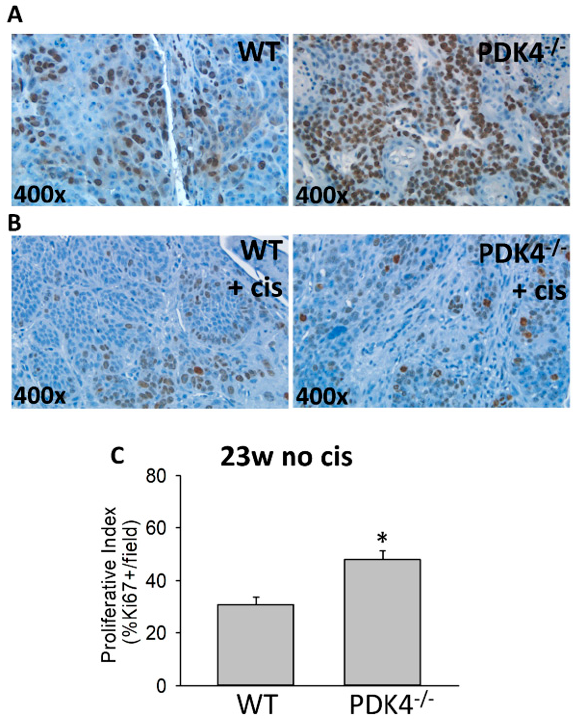
Figure 3. Increased proliferation in PDK4 − / − tumors compared to controls. WT and PDK4 − / − tumors were assessed for Ki67 positivity via immunohistochemistry. Untreated ( A ) and cisplatin-treated ( B ) tumors are presented at the indicated magnification. Proliferative index ( C ) was assessed by evaluating Ki67 positivity in three to four separate fields from each mouse. * p <